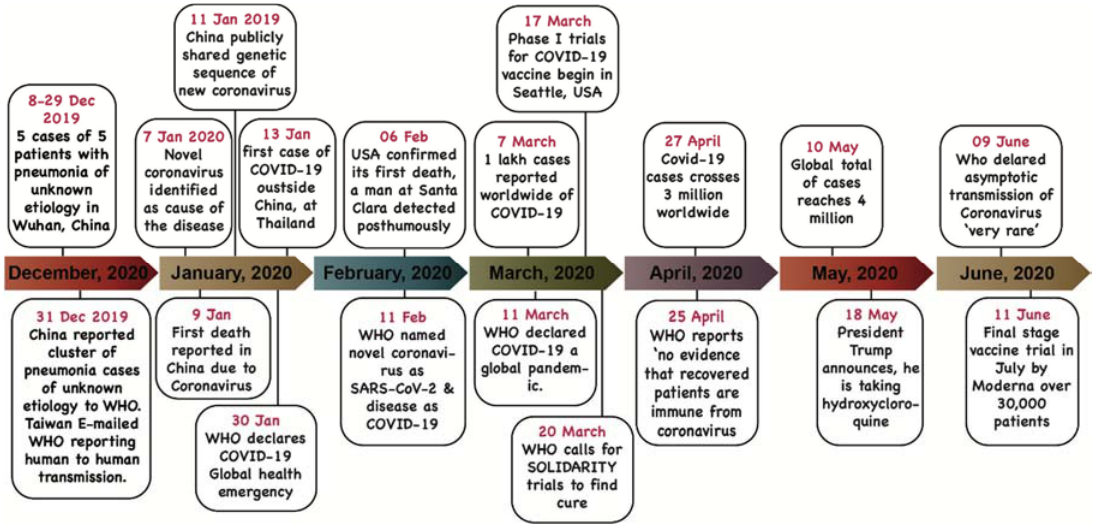
Figure 3. The timeline represents the important events during the novel coronavirus born pandemic